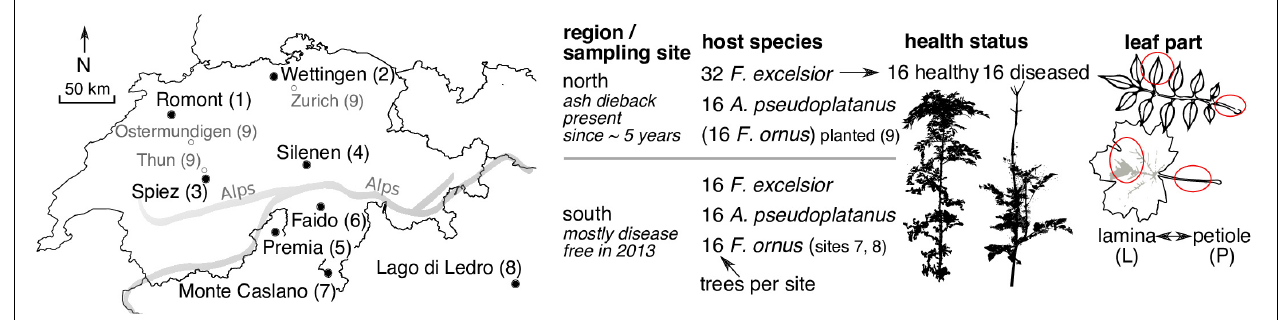
FIGURE 1 | Map of sampling sites (left) and overview of variables examined in this study (right). The names and site numbers in the map are shown according to Supplementary Table S1 in Data Sheet 1 (filled circles). The empty circles with a gray font denote the locations of planted F. ornus trees north of the Alps sampled by Ibrahim et al. (2017). They were collectively assigned to number 9. The thick gray line illustrates the rough course of the main chain of the